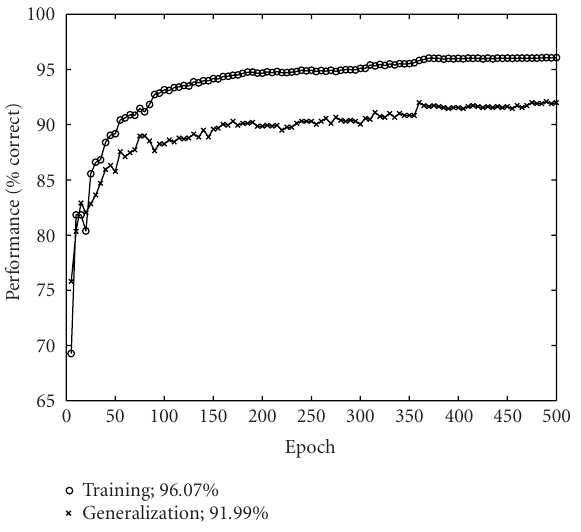
Figure 8: Performance curves during training and testing of the NN classifier with the NRAF short features.